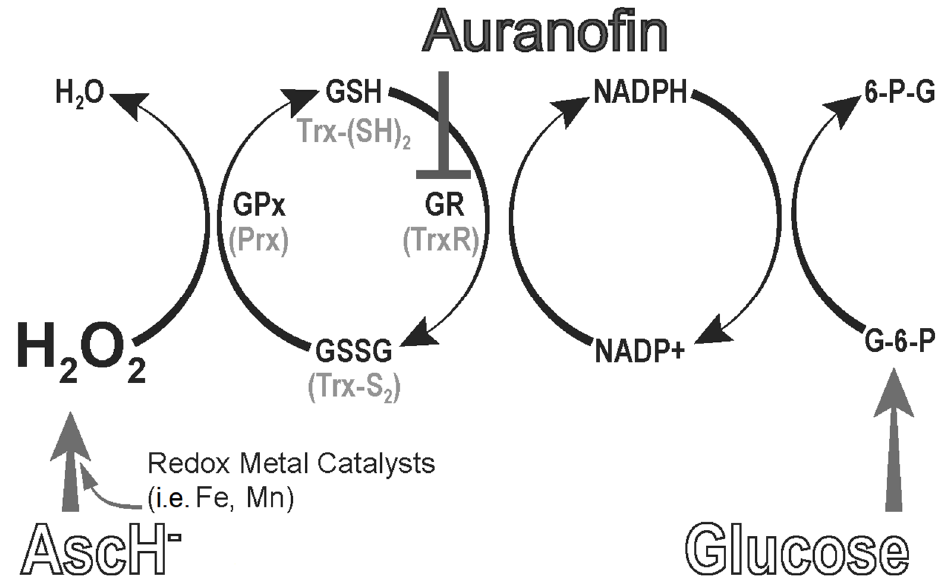
Figure 2. Thioredoxin and glutathione peroxidase (GPx) antioxidant enzyme systems and inhibitors. GSH = glutathione; GSSG = glutathione disulfide; GR = glutathione disulfide reductase; GPx = glutathione peroxidase; Trx-(SH) 2 = reduced thioredoxin; Trx-S 2 = oxidized thioredoxin; TrxR = thioredoxin reductase; Prx = peroxiredoxin; G-6-P = glucose-6-phosphate; 6-P-G = 6-phosphoglucono- δ -lactone. Inhibitors of the pathway are: Auranofin [103].